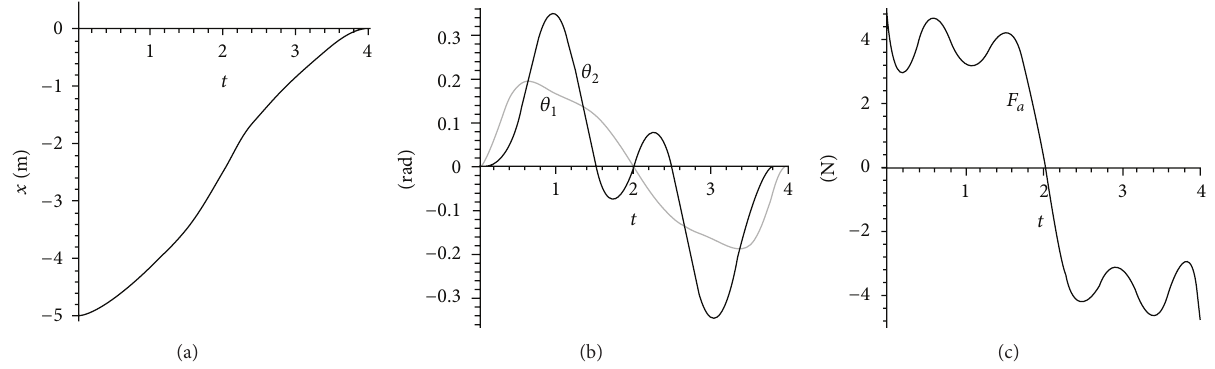
Figure 7: (a) Cart trajectory, (b) swing angles, and (c) force for modified gantry crane (open